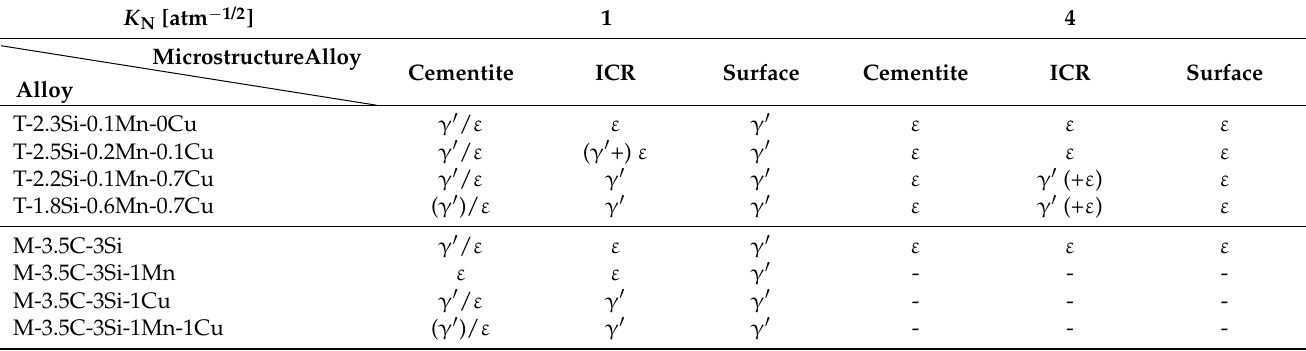
Table 3. Qualitative estimation of phase composition within the compound layers as a function of microstructural constituents (eutectic cementite; intercarbidic regions ICR) and of surface nitrides for white-solidified commercially available cast iron (T) and model alloys (M), nitrided at 540 ◦ C for 16 h at the indicated values of K N